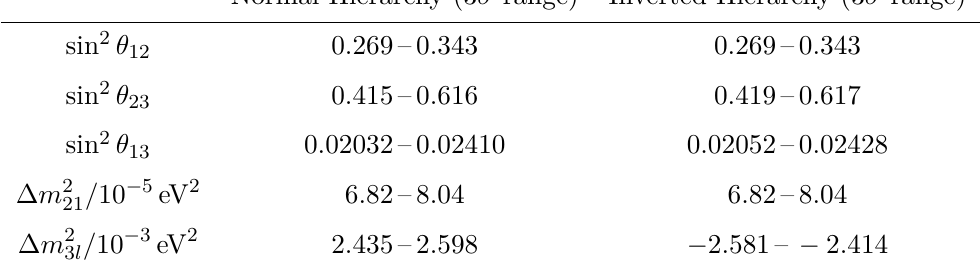
Table 2 . Observed data of the neutrino mass squared differences and the neutrino mixing angles from NuFIT 5.0 [115]. Here, ∆ m 2